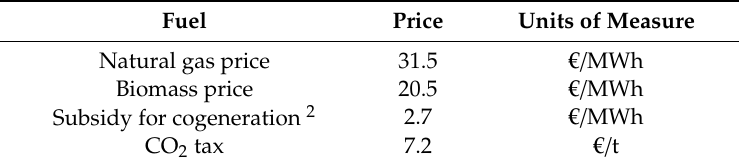
Table 5. Assumed costs of the fuels, including tax and